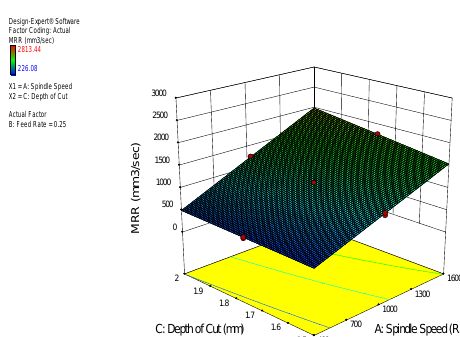
Fig. 10. Influence of Feed rate & Spindle speed on MRR